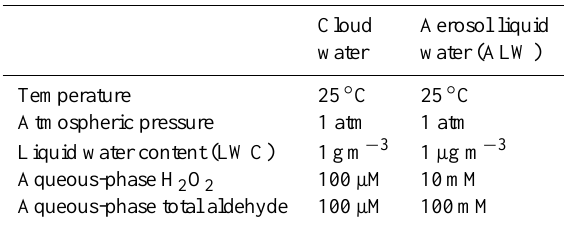
Table 5. Conditions assumed in the atmospheric partitioning simu- lation of 1ppb of aldehydes or H 2 O 2